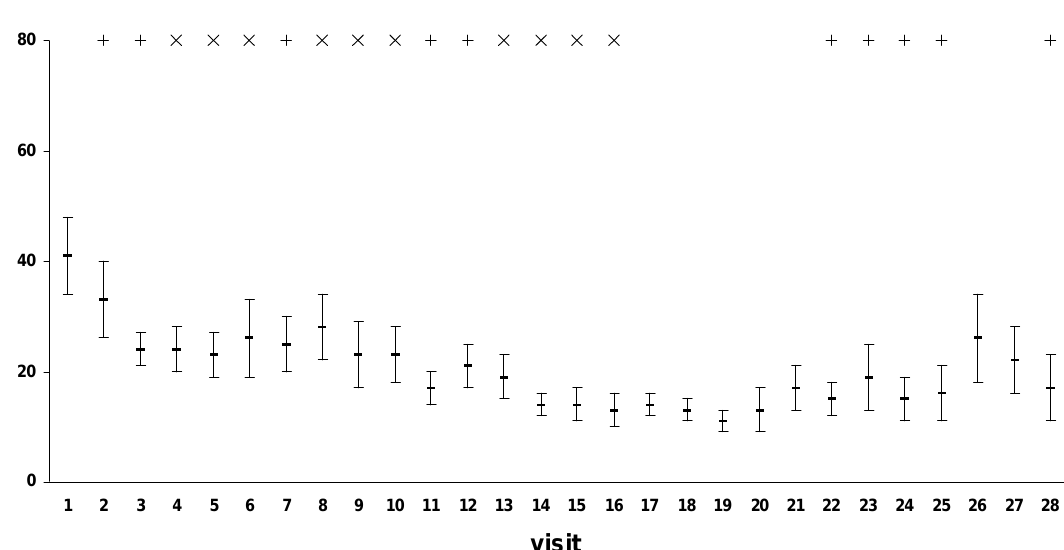
Figure 2.: Serum C-reactive protein concentrations during the course of therapy. Shown is the mean (with stan- dard error of the mean indicated by the error bars) of serum C-reactive protein (CRP) concentrations at baseline (visit 1) and on subsequent visits in approximately weekly intervals. + p < 0.05; × p < 0.01 compared to base- line.